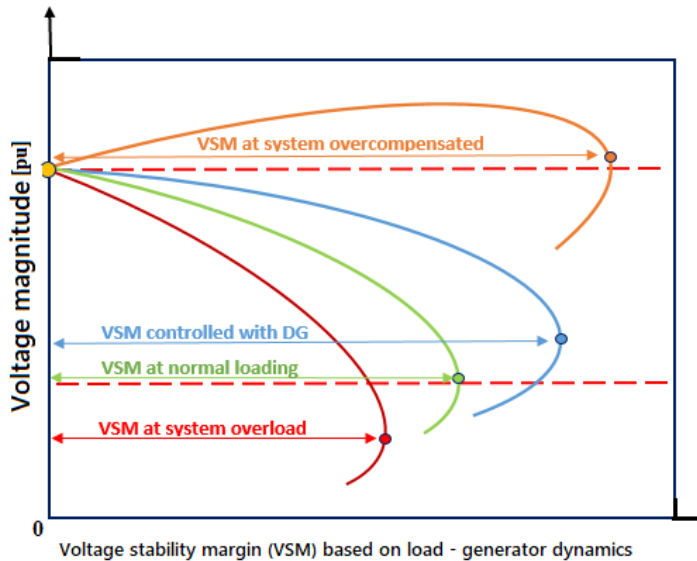
Figure 4. Voltage stability margin at different system